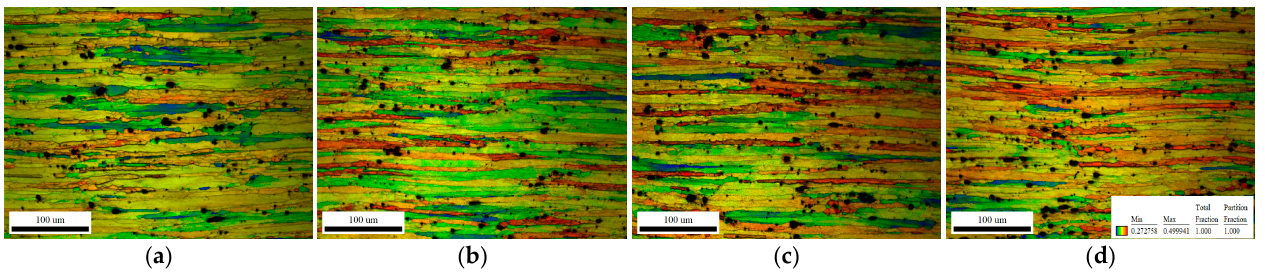
Figure 7. Schmid factor diagrams of fractured samples using {111} <1–10> at different temperatures: